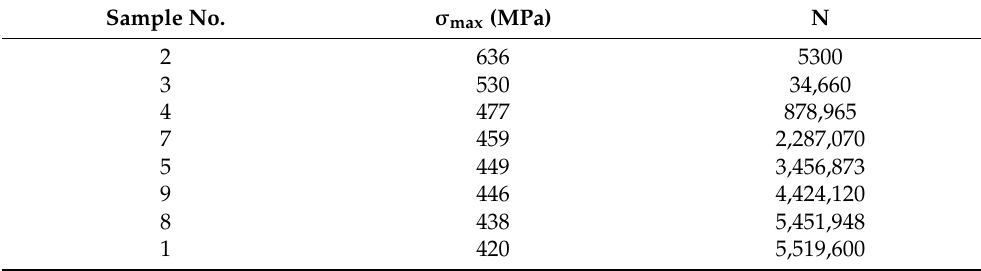
Table 2. Maximum stress σ max and the number of cycles to failure N obtained for Ni/CrC coated 52100-steel samples.